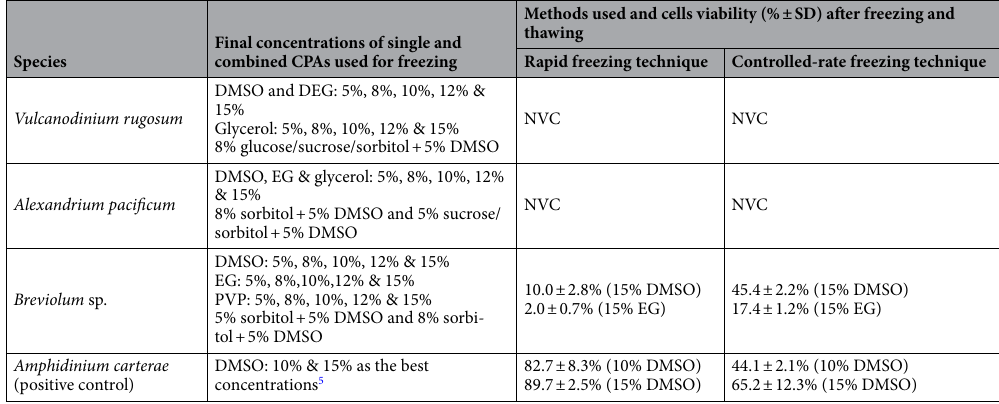
Table 2. Cell viabilities after the rapid freezing and controlled-rate freezing techniques using the selected single and combined cryoprotectant agents (CPAs). NVC No viable cells observed, Values are mean percentage of three replicates ± standard deviation (SD) of the mean. DMSO Dimethyl sulfoxide, DEG Diethylene glycol, EG Ethylene glycol.